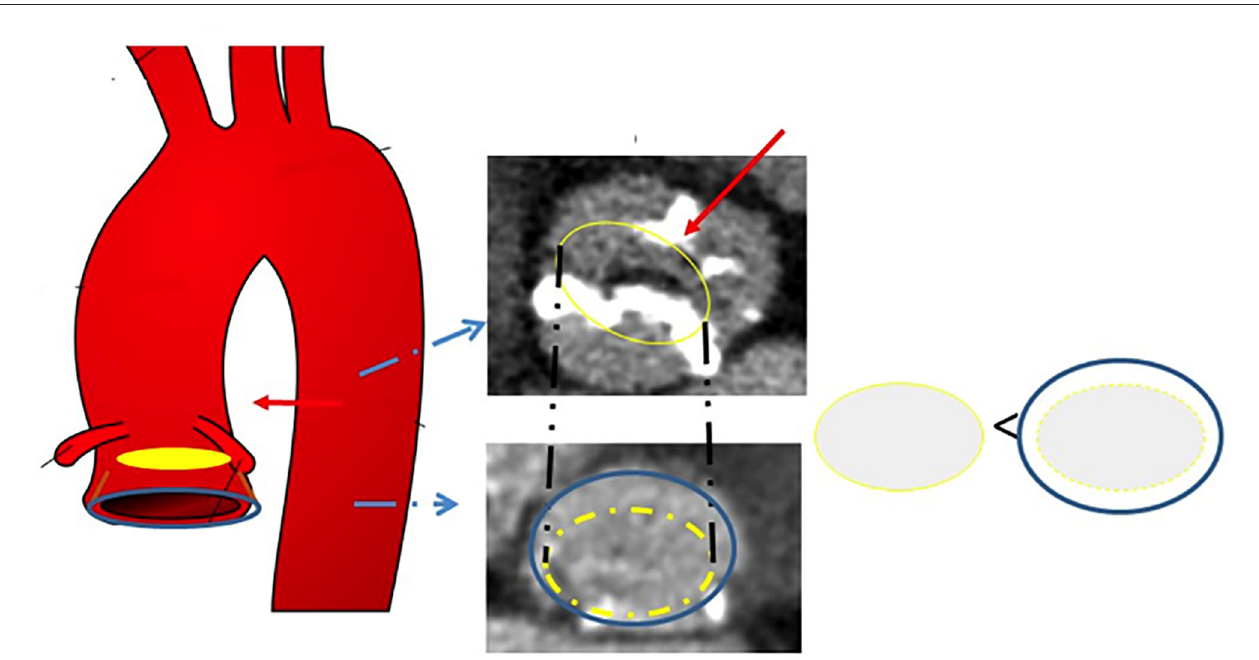
FIGURE 1 | Schematic representation of the effects of the raphe on THV accommodation. The blue circle indicates the annulus, whereas the yellow circle represents the ideal space at the level of the raphe able to accommodate the prosthesis. THV, transcatheter heart valve.